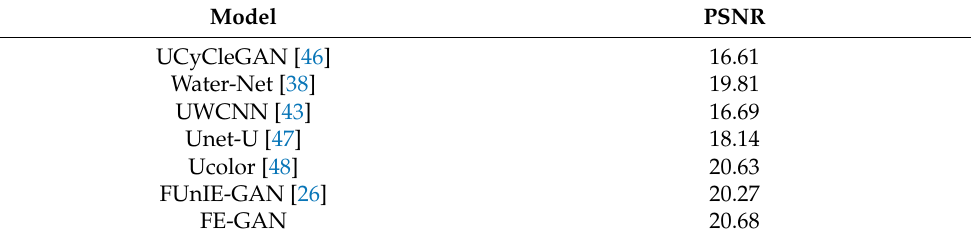
Table 3. PSNR test results of Test-R90. FE-GAN achieved the highest value.